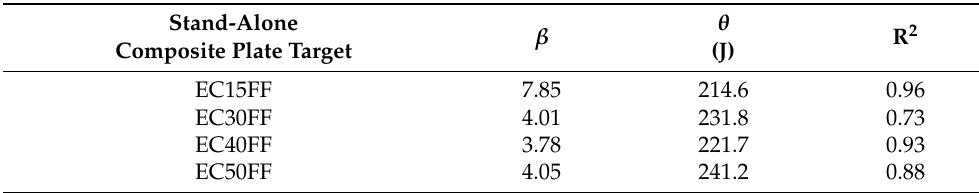
Table 3. Weibull parameters related to stand-alone absorbed ballistic energy of fique fabric reinforced epoxy composites associated with graphs in Figure 5.